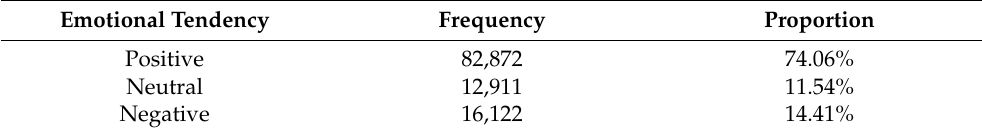
Table 2. Emotional Tendency Gravity